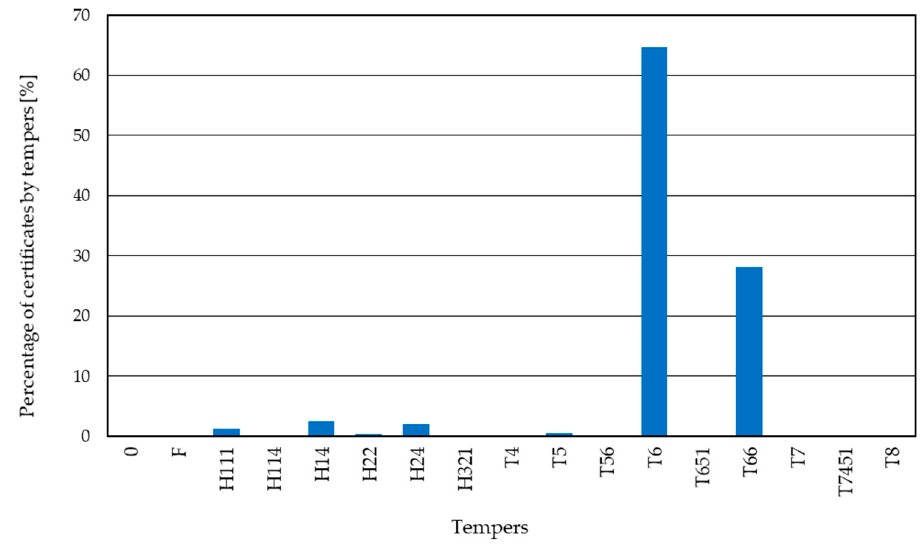
Figure 5. Distribution of obtained material test certificates (tensile test results) by tempers.